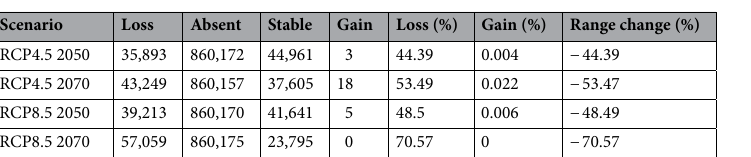
Table 6. Summary of the range change statistics for Rheum webbianum under climate change scenarios compared to current climatic conditions.